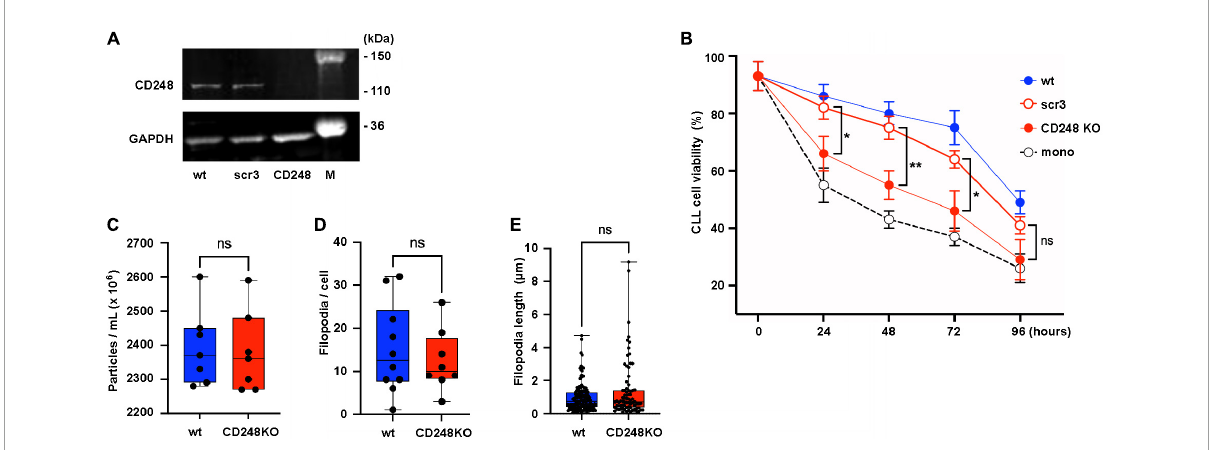
FIGURE7 CD248 contributes to the support of chronic lymphocytic leukemia (CLL) cells. (A) CD248-defective HS-5 cells were generated. The defect was confirmed by western blot in cell lysates of HS-5 wt, CD248 knockout (CD248 KO), and the scrambled control (scr3). (B) Primary CLL cells (1.5 × 10 6 /ml) were cocultivated with HS-5 cell variants as indicated (1 × 10 4 /ml) or without HS-5 cells. After indicated time points, the non-adherent CLL cells were suspended and transferred to another well for the cell viability measurement using CellTiter-Glo2 as indicated. The results show the means ± SEM of nine different patients. Statistics is shown between CD248 KO and the scr3 control at indicated time points. (C) To test the influence of CD248 on the release of particles, wt and CD248-defective HS-5 cells were cultivated for 24 h in medium with extracellular vesicles (EV)-depleted serum. Then, the particles count was determined in the supernatants of seven aliquots by nanoparticle tracking analysis. (D,E) Filopodia were identified in fixed and F-actin-stained confocal images of wt and CD248 KO HS-5 cells. The filopodia count per cell and filopodia length were measured and calculated using the FiloQuant plugin of Fiji software (19). The non-parametric, two-tailed t -test (Mann–Whitney) was performed when indicated (* P < 0.05, ** P < 0.01, ns, not